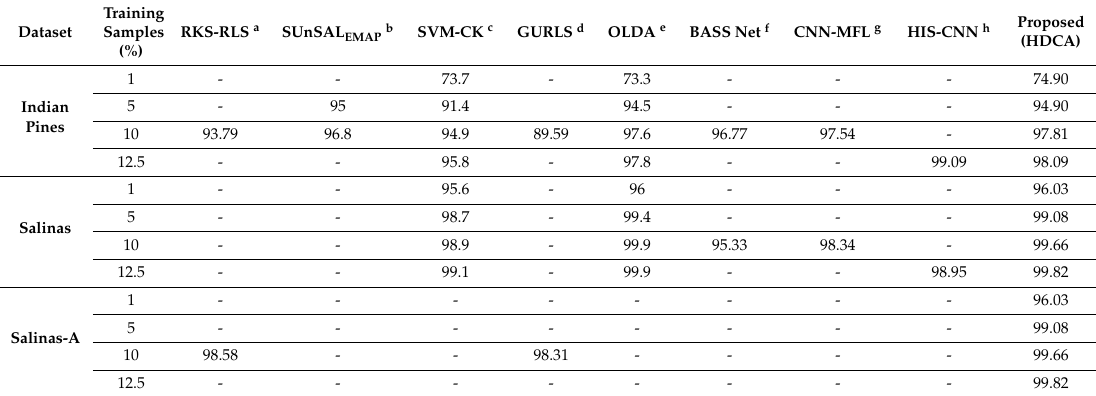
Table 9. Overall accuracies of the proposed method compared to the results of other algorithms in previous